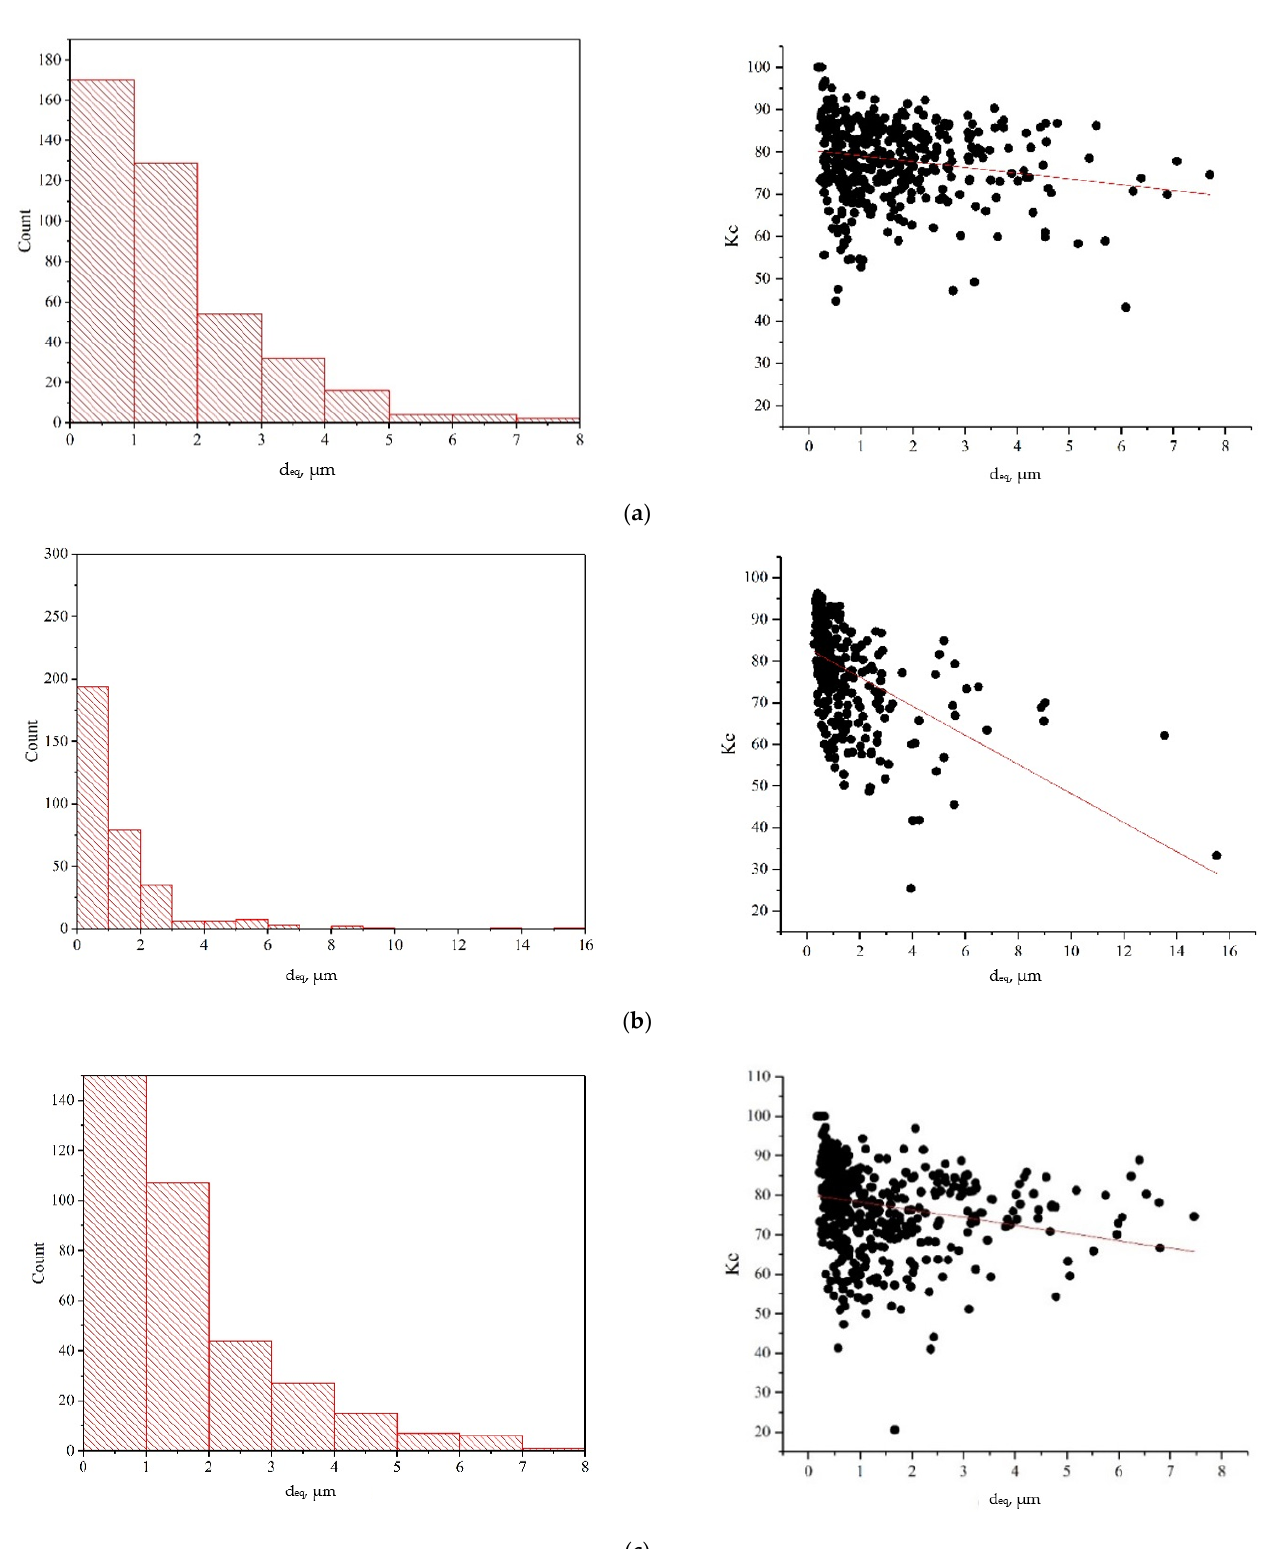
Figure 7. Histograms of dimple diameters and diagrams of dimple shape coefficients on fracture zones of specimens made of the VT23 alloy rolled in the transverse direction after the introduction of impulse energy due to impact-oscillatory loading followed by static tensioning: ( a )— ε і mp = 0.81%; ( b )— ε і mp = 2.56%; ( c )— ε і mp = 4.56%. The fracture of specimens after the realization of the DNP ( ε і mp = 2.56%) is also char- acterized by a dimple structure, which, however, differs significantly from the previous